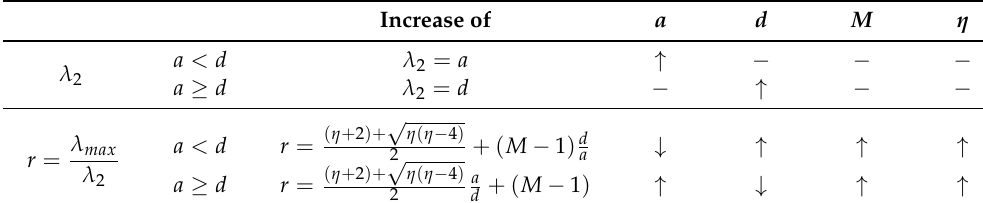
Table 3. Changes of λ 2 , r with a , d , M , η of multilayer Networks-C. Increase